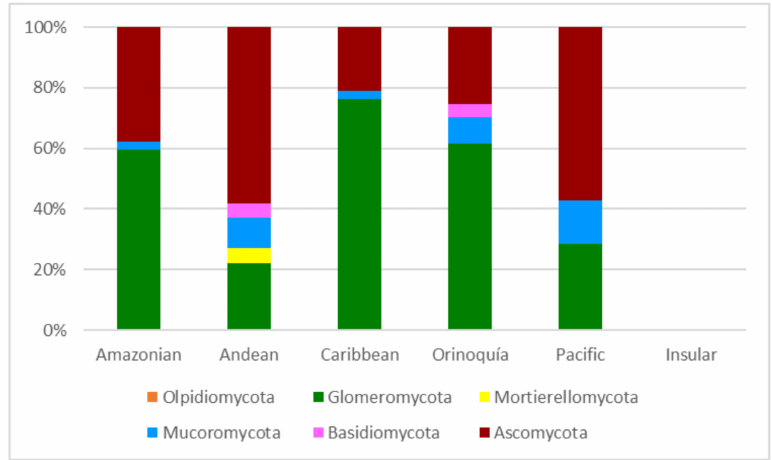
Figure 3. Soil microfungil at phylum level (expressed in %) recorded from the natural regions of